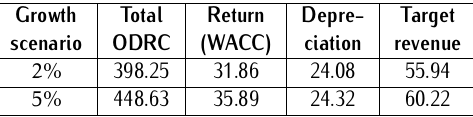
Table 5. Target yearly distribution revenue ($000)